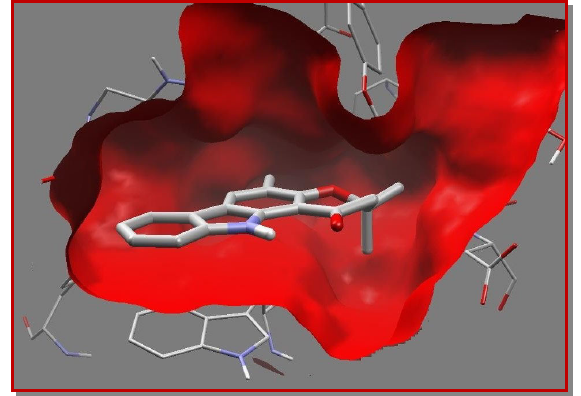
Figure 4: Favorable steric indications of euchrestifoline (Ecf) with binding pocket inside active site of AChE. Hydrogen atoms except polar ones are omitted for